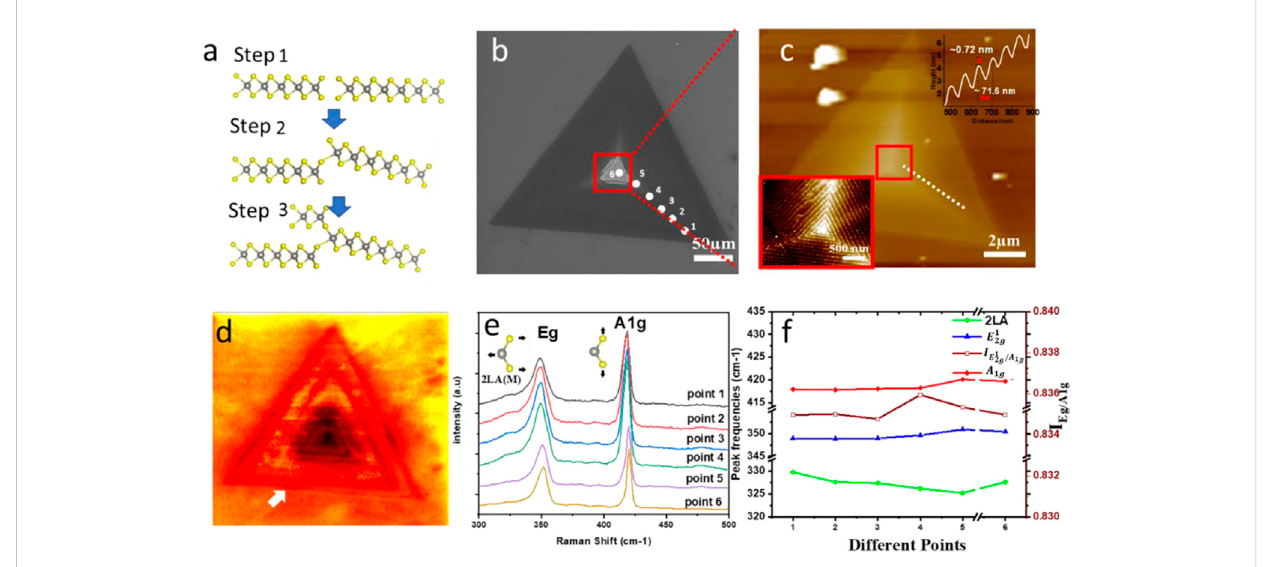
FIGURE 3 Screw dislocation growth of single spiral. (A) Illustrations of the single spiral structure (B) SEM imageof single spiral structure of WS 2 (C) AFM images corresponding the marked areas in SEM image. (D) Raman intensity mapping of E 1 2 g mode (350 cm -1 ). (E,F) Intensity ratios and peak frequencies of WS 2 Raman modes. (E) Frequencies of the ( 2 LA , E 1 2 g , A 1 g ) Raman modes as a function of thickness (different positions mean different thicknesses) for λ exe = 633.TheerrorbarscorrespondtothestandarddeviationsandEachpointrepresentsanaverageoversixdifferentpositions (E) Thickness-dependent intensity ratios of I E 1 / I A (E,F) of six points from edge to center, as marked in SEM 1 g 2 g